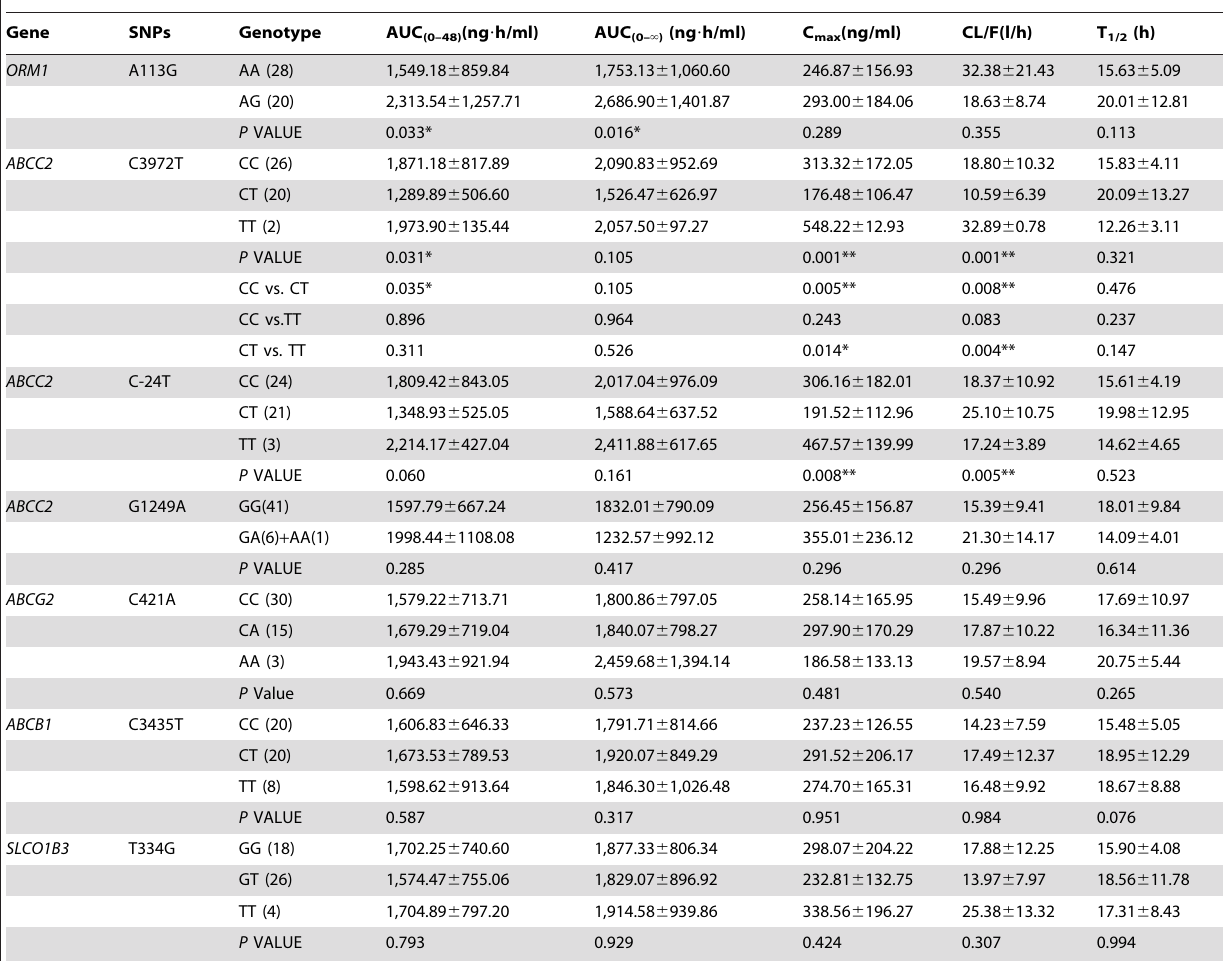
Table 4. Telmisartan PKs of 48 health males with different genotypes.